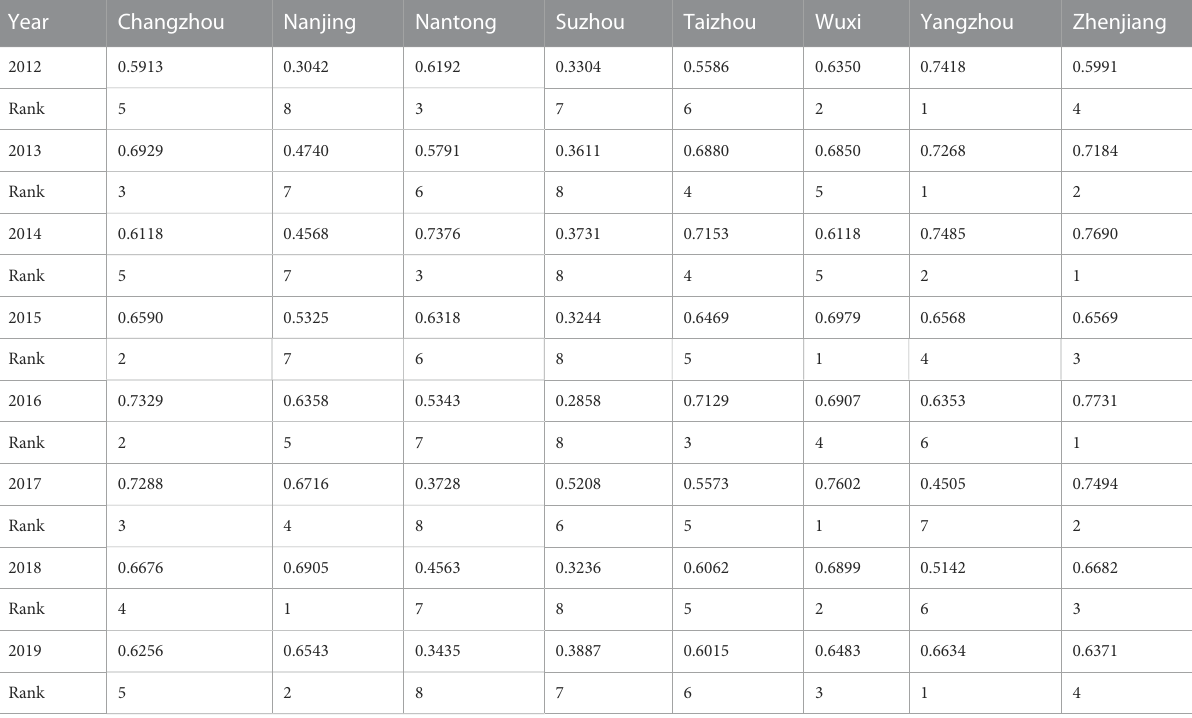
TABLE 12 Water environment carrying status index of eight cities along the Yangtze River in Jiangsu Province from the horizontal year view by integrated method.